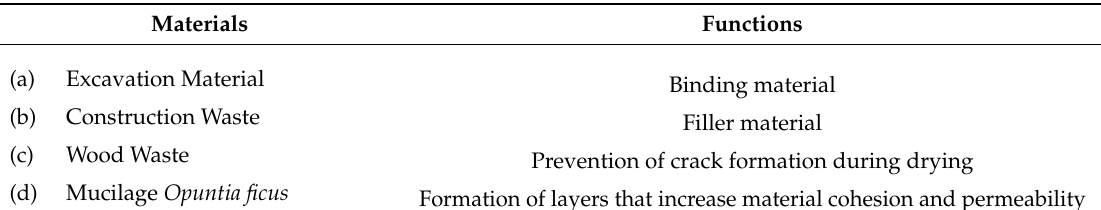
Table 8. Functions of